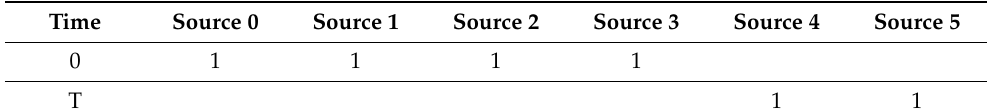
Figure 10. Topology 2. Figure 11 is a graph of the training results of the RL-based scheduler in topology